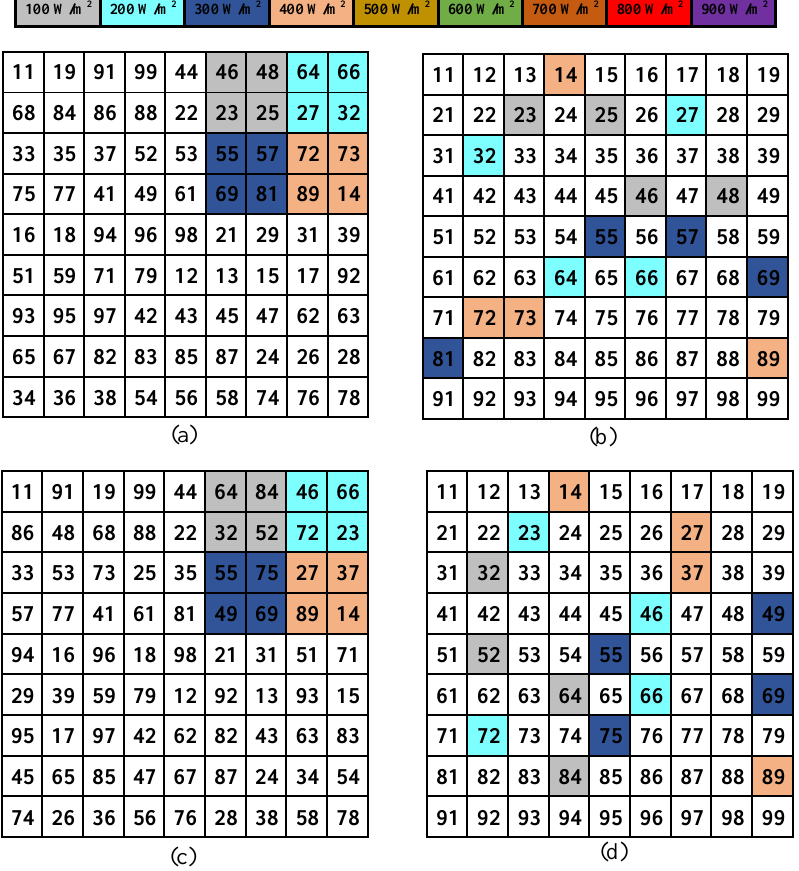
Figure 4. ( a ) OEP; ( b ) Shade dispersion of OEP; ( c ) IOEP; ( d ) Shade dispersion of IOEP for 9 × 9 PV array at Top-Right PSC. The voltage–power characteristics of case-2 (Top-Right) are shown in the Figure